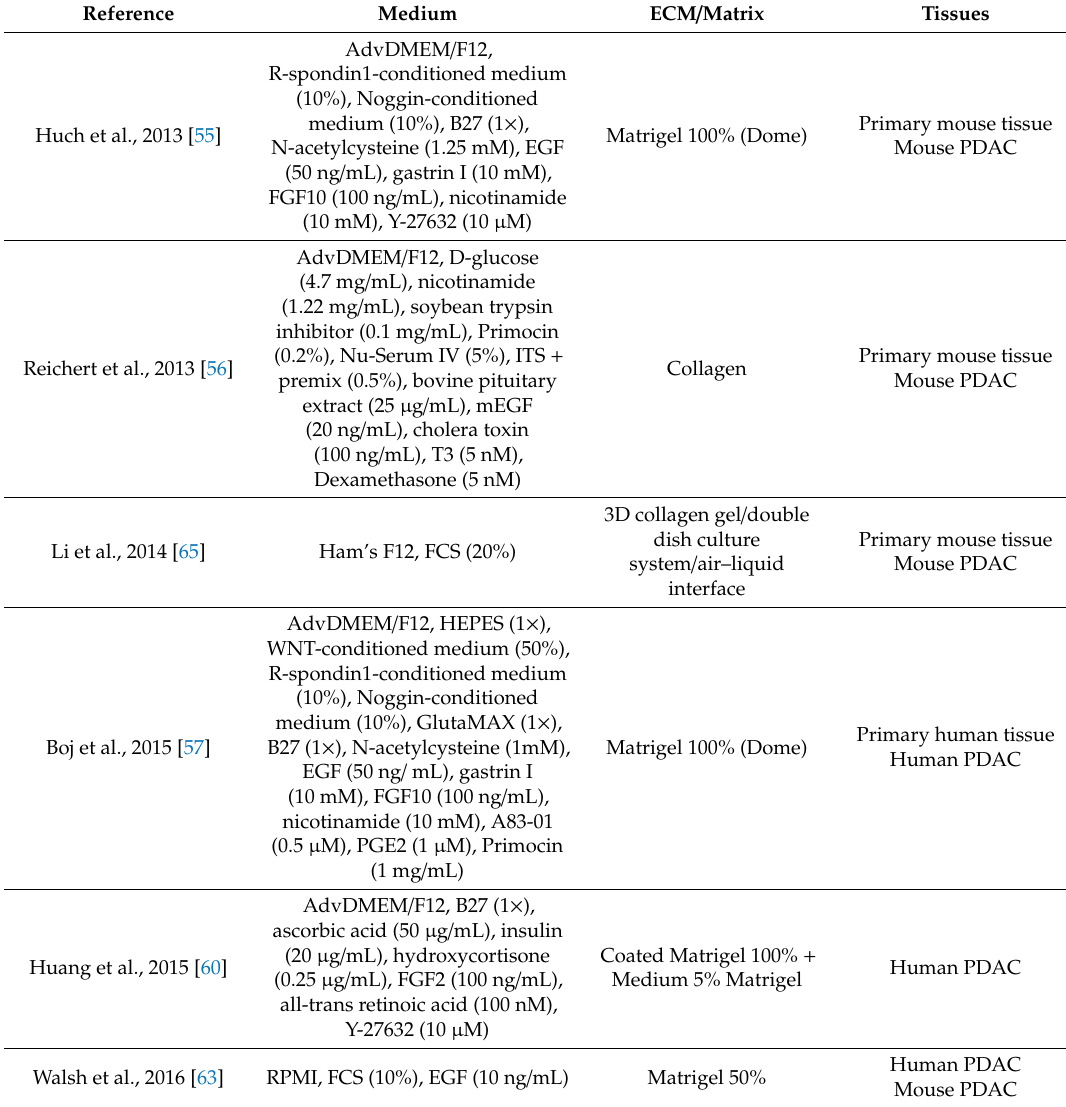
Table 1. Summary of the di ff erent methods to culture mouse and human